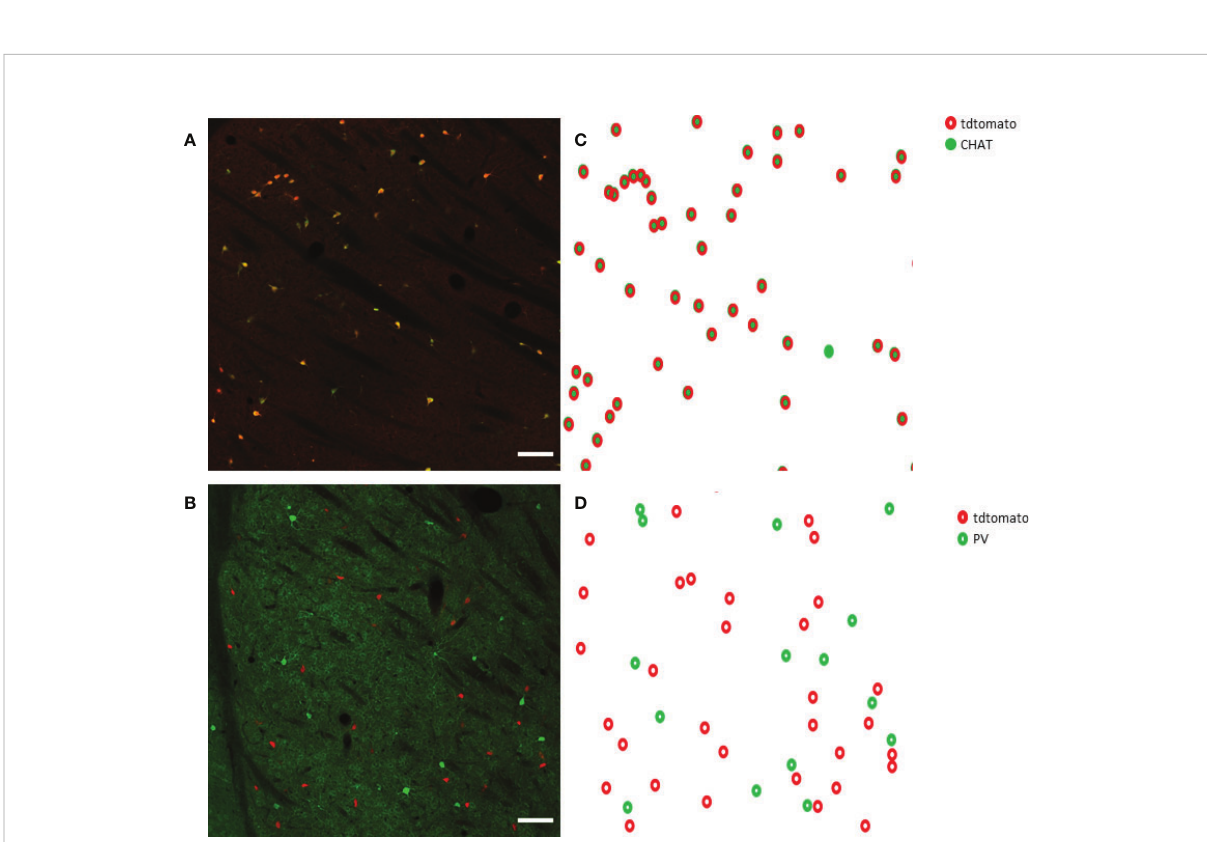
FIGURE 2 CHAT and parvalbumin (PV) staining in the striatum from a ChAT-Cre-tdTomato transgenic adult female mouse. Representative images show CHAT- and PV-positive cells in green in a sagittal section of the striatum in Panels (A, B) respectively. TdTomato-expressing cells are presented in red. CHAT+ cells are marked with fi lled circles in Panel (C) , while open green circles represent PV+ cells in Panel (D) . TdTomato-expressing cells are marked with open red circles in both Panels (C, D) . 20x magni fi cation, scale bar presents 100 m m.